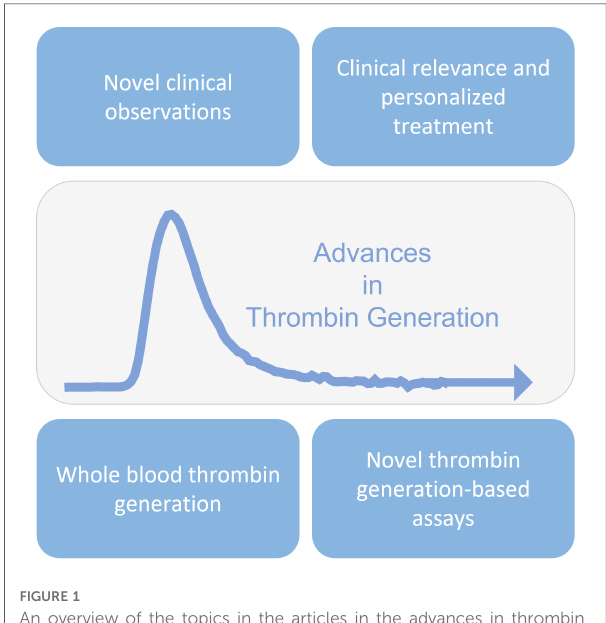
FIGURE 1 An overview of the topics in the articles in the advances in thrombin generation